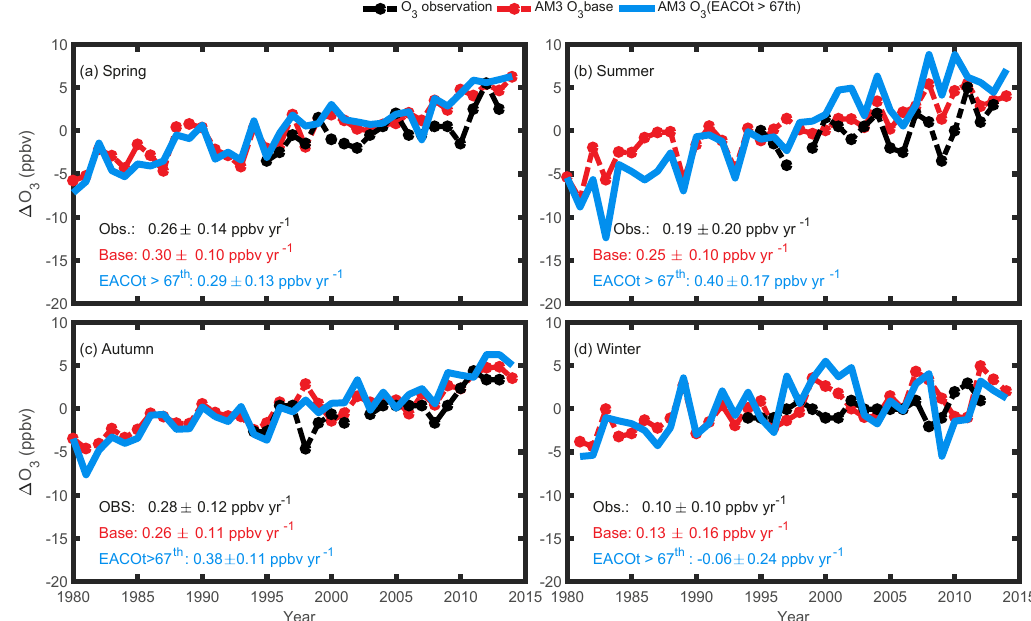
Figure 5. Comparison of seasonal median ozone anomalies at Mt Waliguan over the period of 1980–2014 from available observations (black), GFDL AM3 BASE simulations (red), and under conditions with strong transport from East Asia (EACOt > 67th, blue) for (a) spring, (b) summer, (c) autumn, and (d) winter. The linear trends (with the 95% confidence intervals) over the period of 1994–2013 and correlations between observations and models are